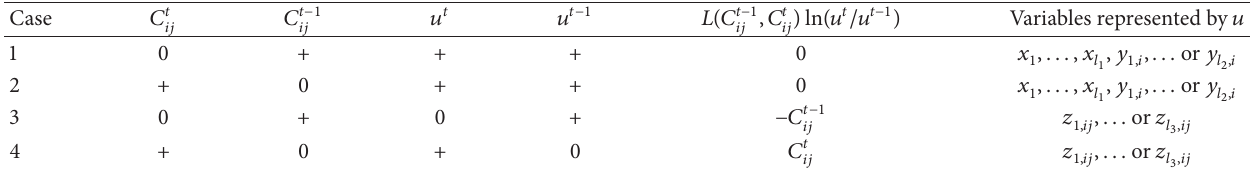
Table 1: Exceptional cases in LMDI